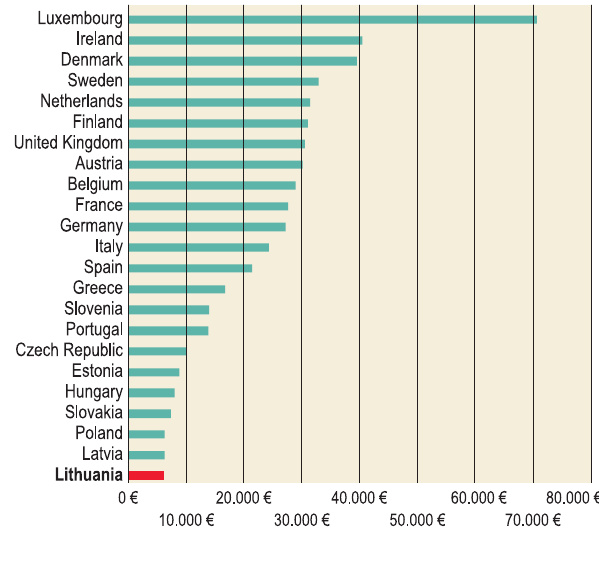
Fig. 2. GDP per capita in Europe in 2006; source: